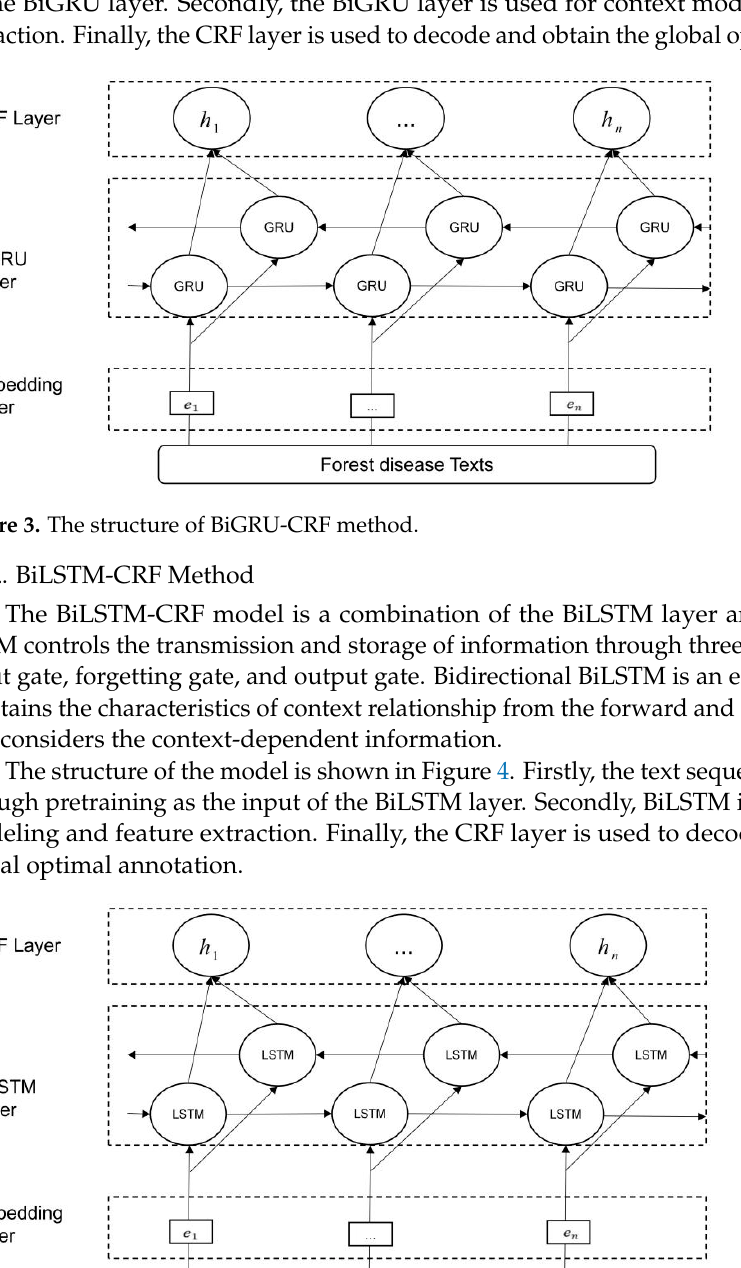
Figure 5. The structure of Transformer-BiLSTM-CRF method.